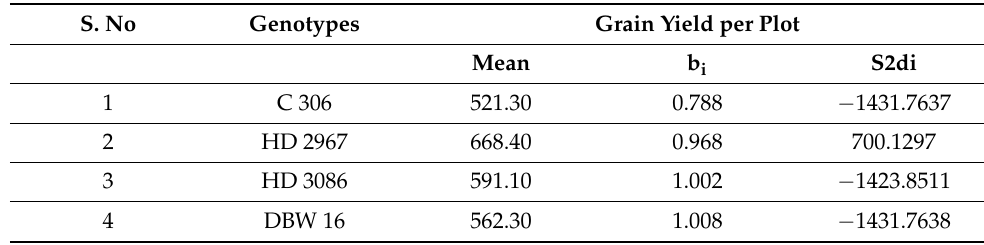
Table 5. Stability parameters as per Eberhart and Russell, 1966 model for grain yield per plot of 100 wheat genotypes tested across the